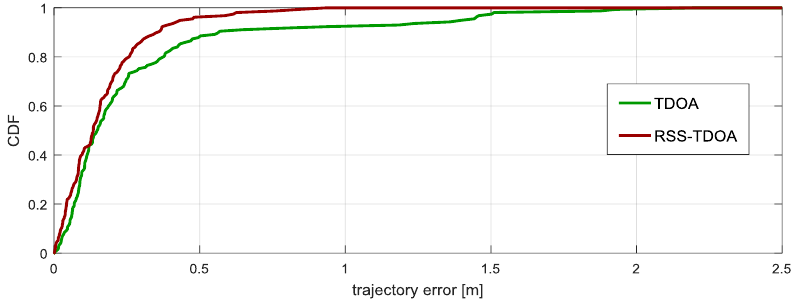
Figure 17. Empirical CDF of tracking error for all tested algorithms.